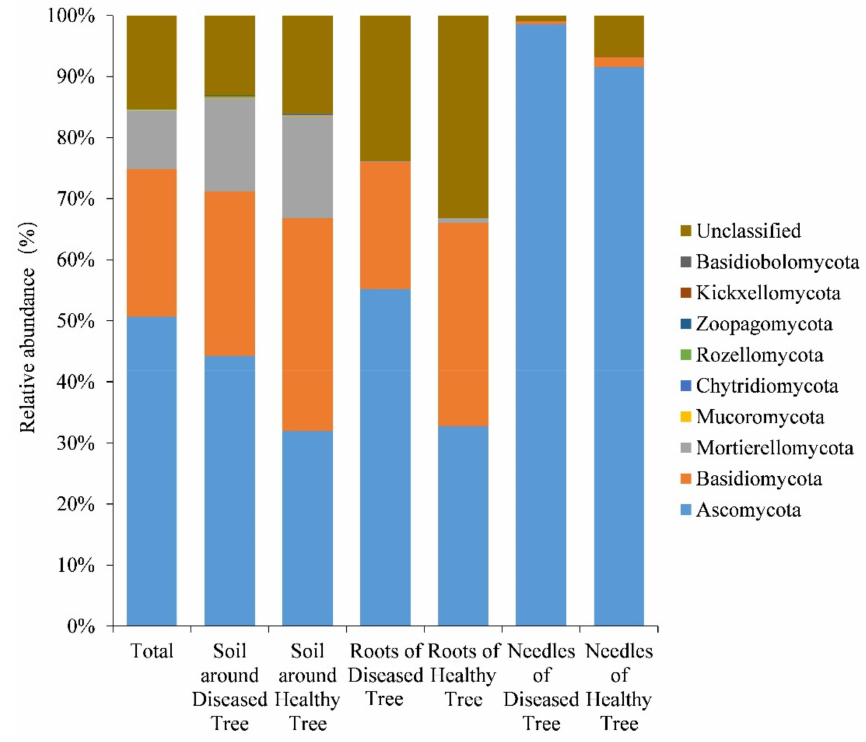
Figure 4. Relative abundance of fungal phyla in soil, roots, and needles around and of healthy and diseased